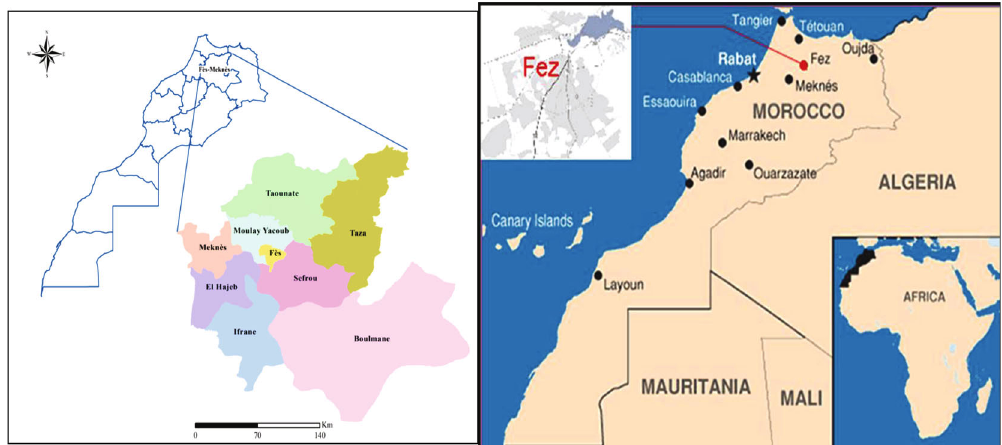
Figure 1: Geographic location of the study area (Fez Prefecture). Source: satellite location map of Fes, latitude/longitude: 34 ° 2 ′ 14 ″ N/4 ° 59 ′ 59 ″ W